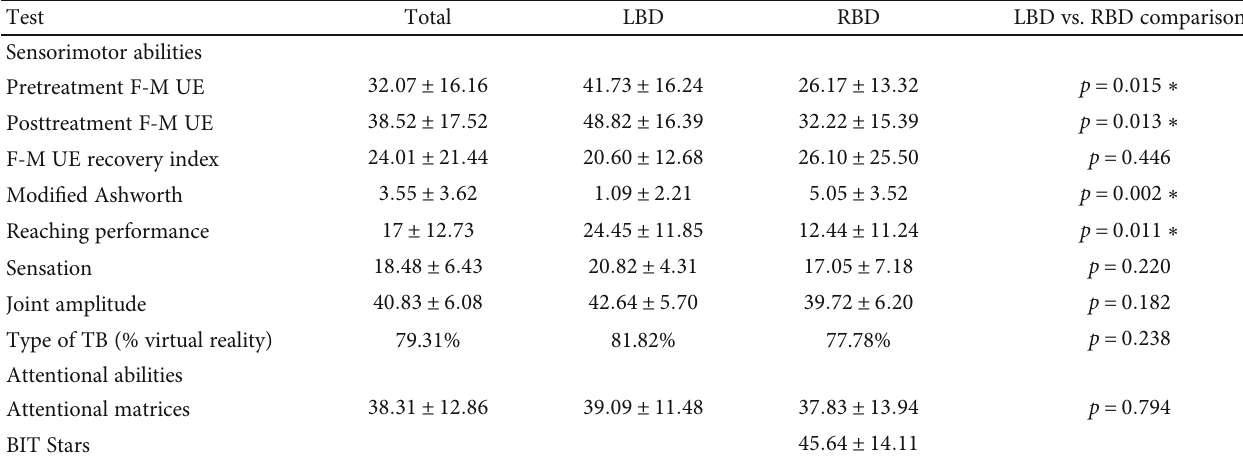
Table 1: Values for whole sample and divided for damaged hemisphere.